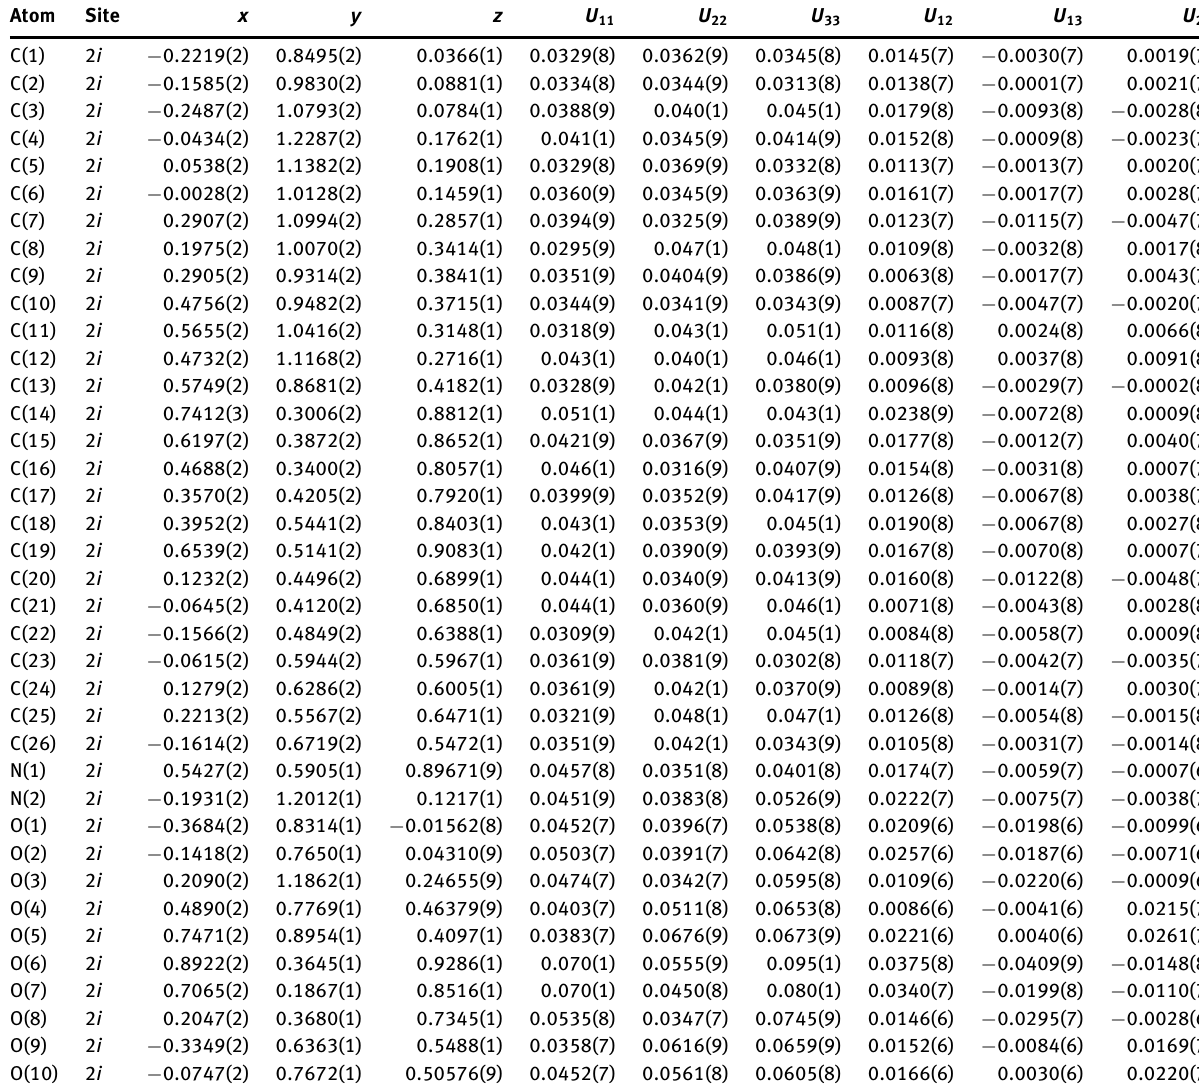
Table 3: Atomic displacement parameters (Å 2